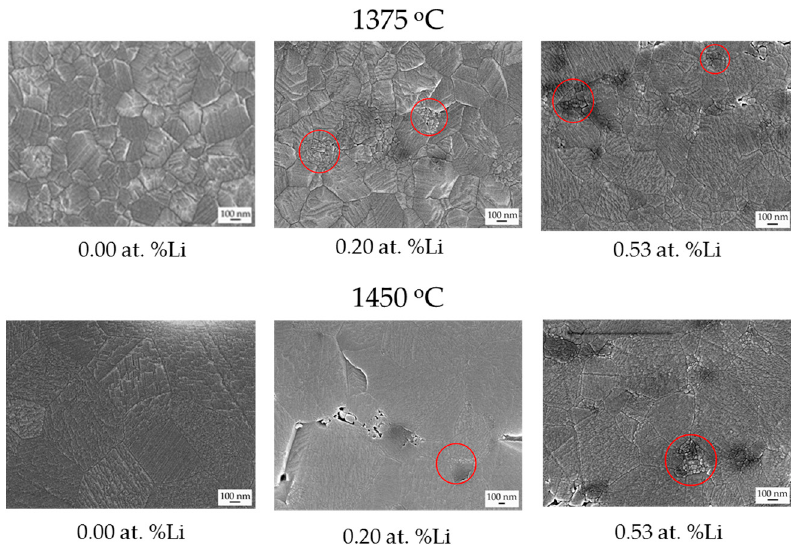
Figure 6. Micrographs of the undoped, 0.2 and 0.53 at. % Li-doped MgO·1.21Al 2 O 3 samples after heat-treatment at 1375 and 1450 °C for 24 h. The presence of the fine grain clusters is marked by red circles. The undoped MgO·1.21Al 2 O 3 sample showed monotonic grain growth with temperature and